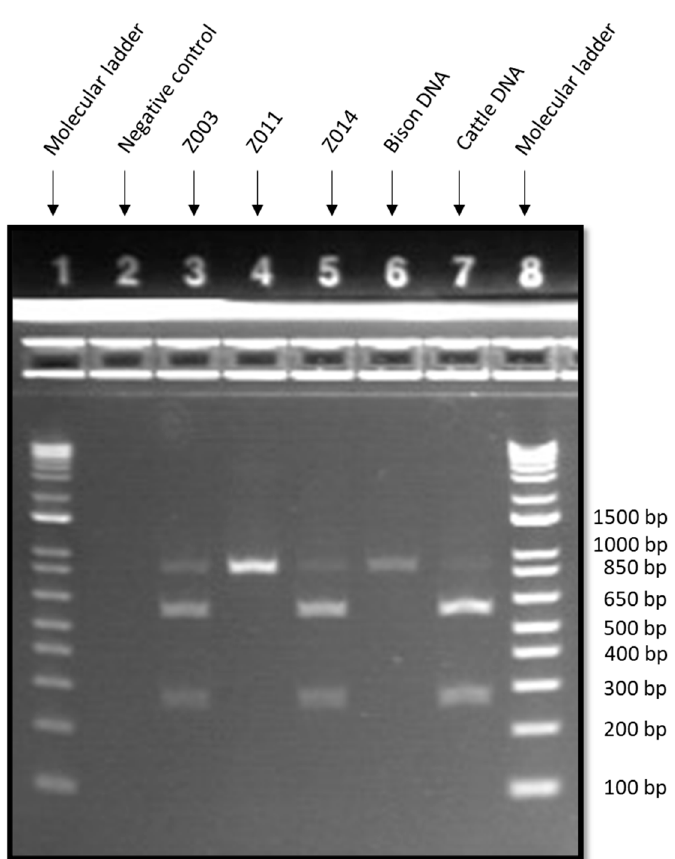
Figure 1. Gel electrophoresis results of polymerase chain reaction-satellite fragment length polymorphism (PCR-SFLP) (satellite 1.711 with Taq I digest) for bison products that were positive for domestic cattle with DNA barcoding. Well assignments are as follows: E-Gel TM 1 Kb Plus DNA ladder (wells 1 and 8), non-template control (well 2), Z003 (well 3), Z011 (well 4), Z014 (well 5), bison DNA positive control (well 6), and domestic cattle DNA positive control (well 7). Table 4. Summary of mislabeled bison products identified in this Table 3. Results of PCR-SFLP for bison products ( n = 3) that tested positive for domestic cattle with DNA barcoding. The satellite 1.711 PCR amplicon was digested with Taq I restriction enzyme to determine the species present in the sample.